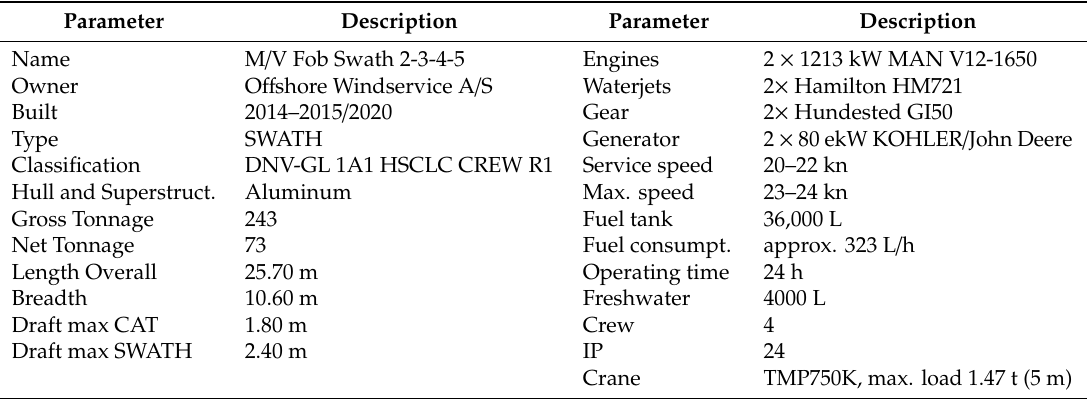
Table 1. Specification of M/V FOB SWATH 2,3,4,5 and 6 [52,53].